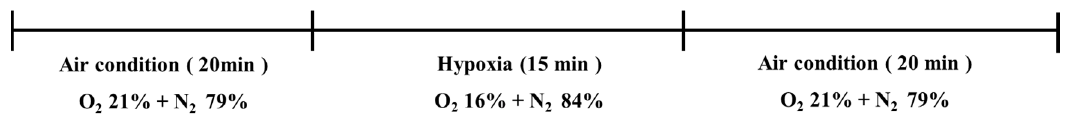
Figure 3. Respiratory challenge protocol.